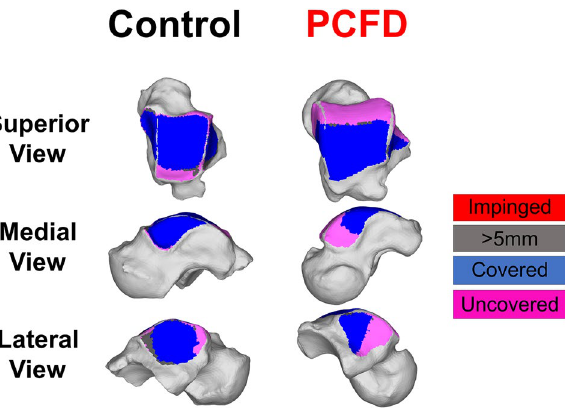
Figure 6. Superior, medial, and lateral views of the talus showing Coverage Maps of a Control and a Progressive Collapsing Foot Deformity (PCFD) patient. Coverage Maps identify regions of impingement (red), normal joint interaction (Blue), articular uncoverage (Pink), and interactions greater than 5 mm (Dark